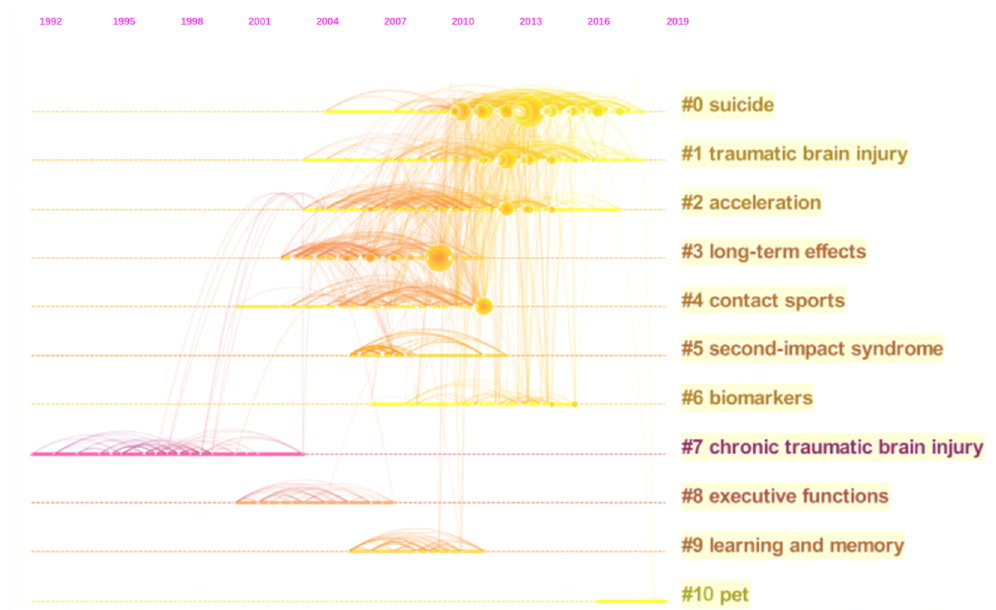
Figure 7. The cluster view of the knowledge map based on reference co-citation analysis (RCA) of the CTE field from 1999 to 2019.